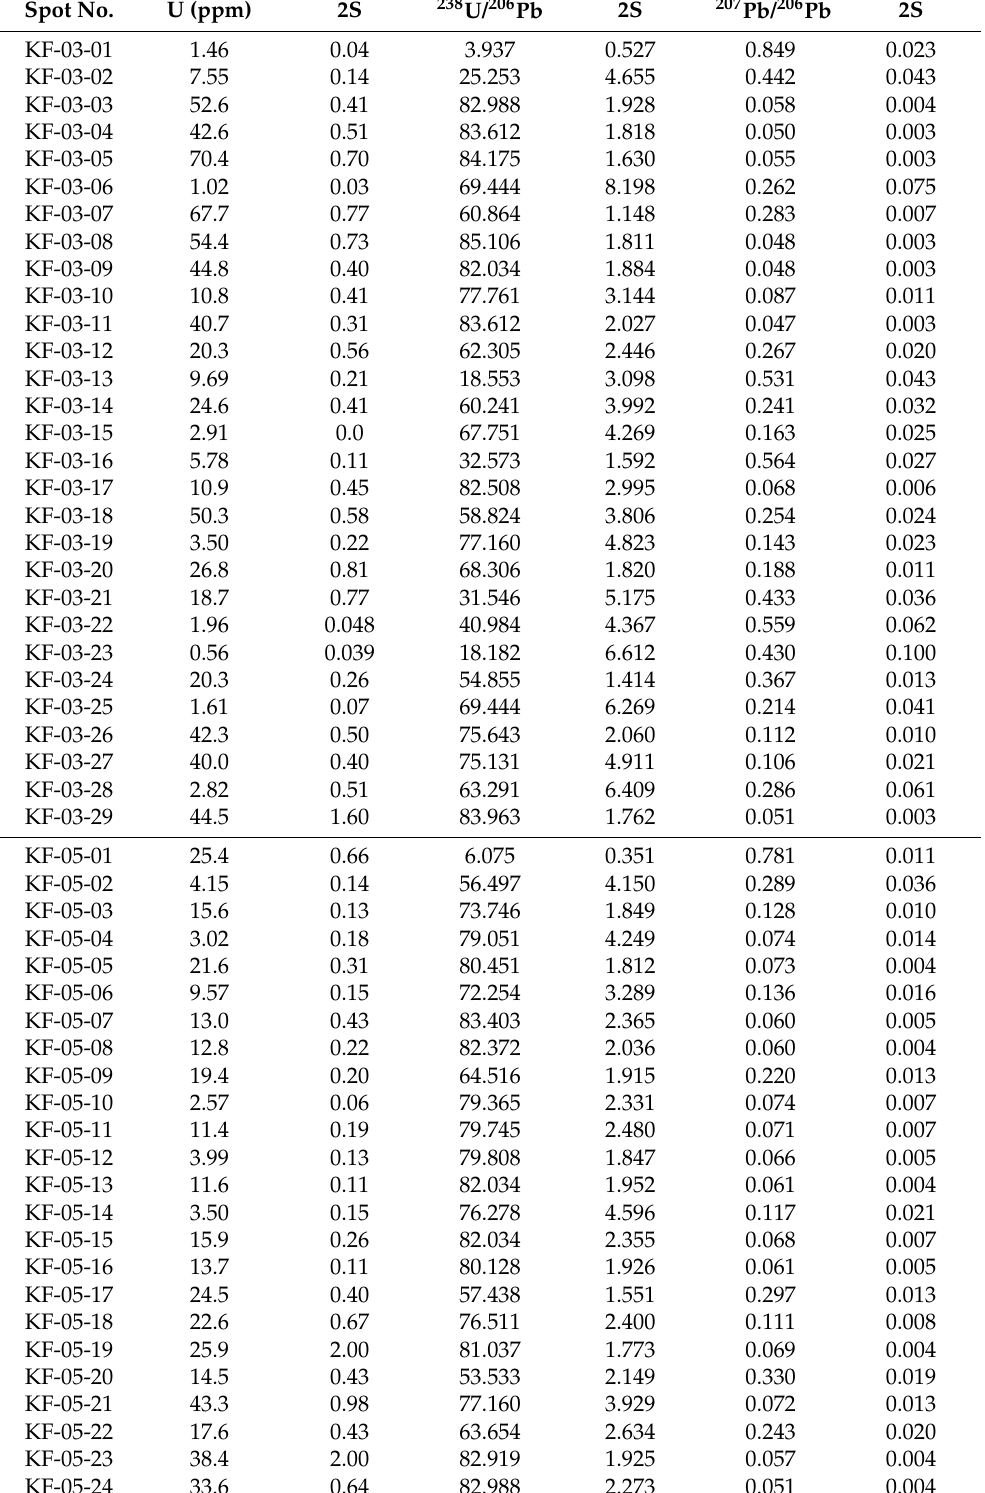
Table 1. U–Pb isotopic ratios of cassiterite samples analyzed by LA–ICP–MS single spot analysis. Spot